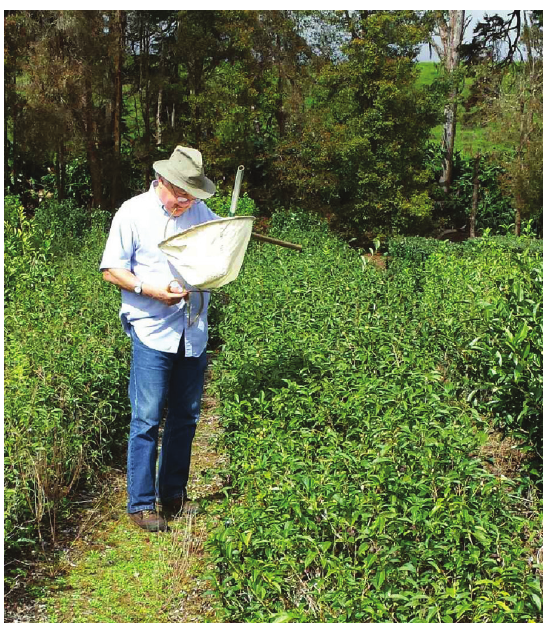
Figure 2. Tom Henry collecting Heteroptera in Hawaii,